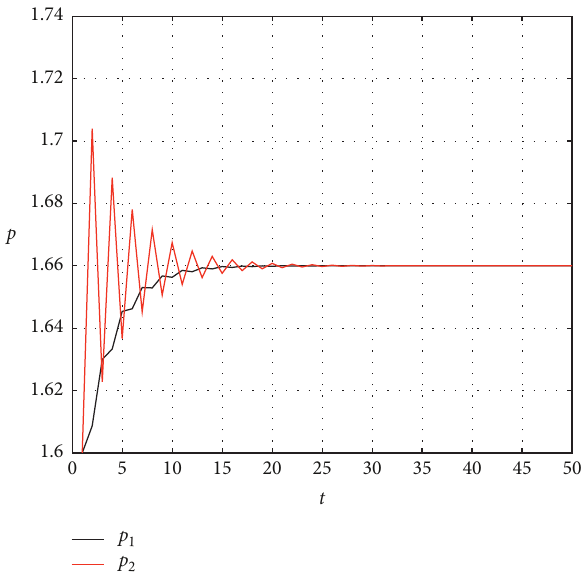
Figure 9: Price temporal changing ( β � 0.35, p